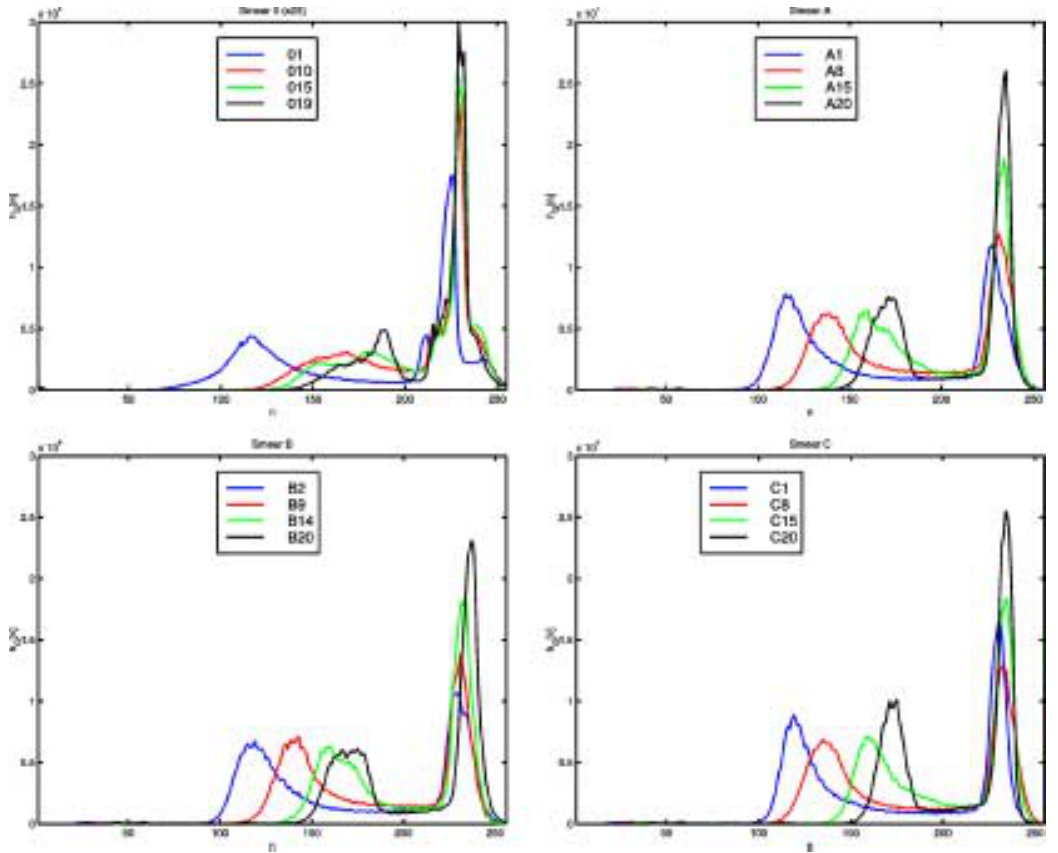
Fig. 5. Histograms of some images from the four smears test (for each one, the green component histogram of 4 random images is depicted): the histograms are typically bi-modal but the optimal value which separates the two categories depends on the image. This figure can be viewed on